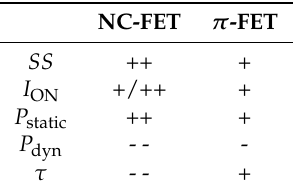
Table 2. A qualitative summary of the device performance of the NC-FET vs. π -FET.